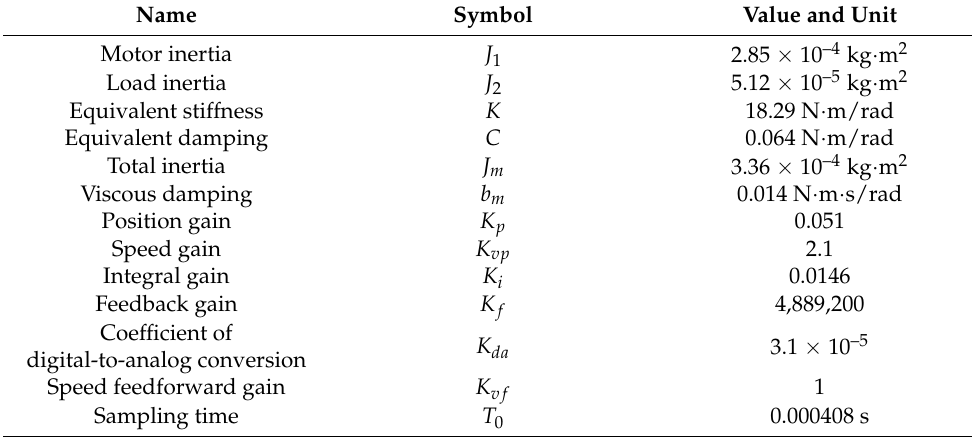
Table 1. Relevant parameters of simulation model.